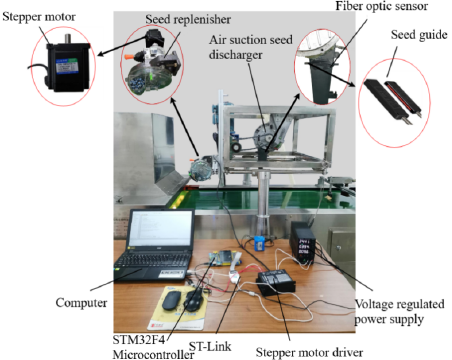
Figure 11. Corn concentrate seeding leakage detection and compensation system composition.